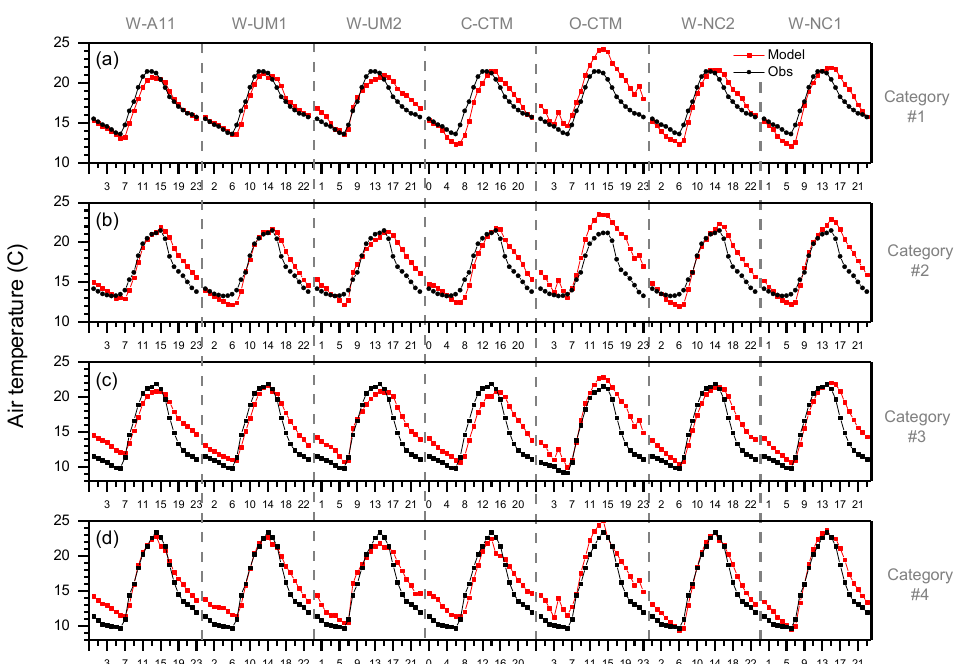
Figure 4. Diurnal composite observed (black) and modelled (red) 2 m temperature at Westmead during SPS-II. Panels a–d represent each of the four radon-based atmospheric mixing categories (Table